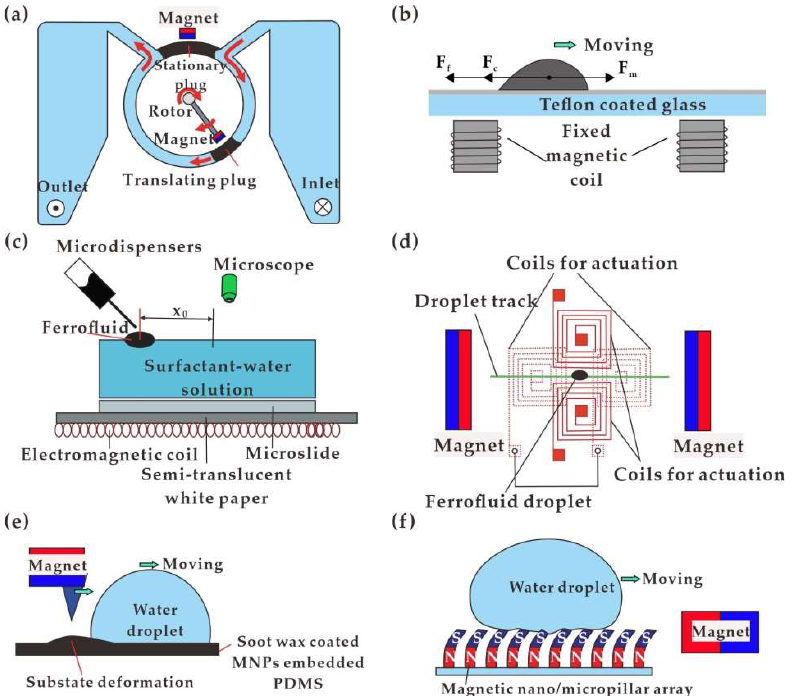
Figure 3. Droplet transportation in magnetic actuation: ( a ) Ferrofluid plugs with rotating permanent magnets [115]; ( b ) Ferrofluid droplet with sliding permanent magnets [73]; ( c ) Ferrofluid droplets with electromagnetic coils [56]; ( d ) Ferrofluid droplets with permanent and electromagnetic fields [122]; ( e ) Water droplet moving on substrate deformation [128]; ( f ) Water droplet moving based on magnetic nano/ micropillar arrays [130].